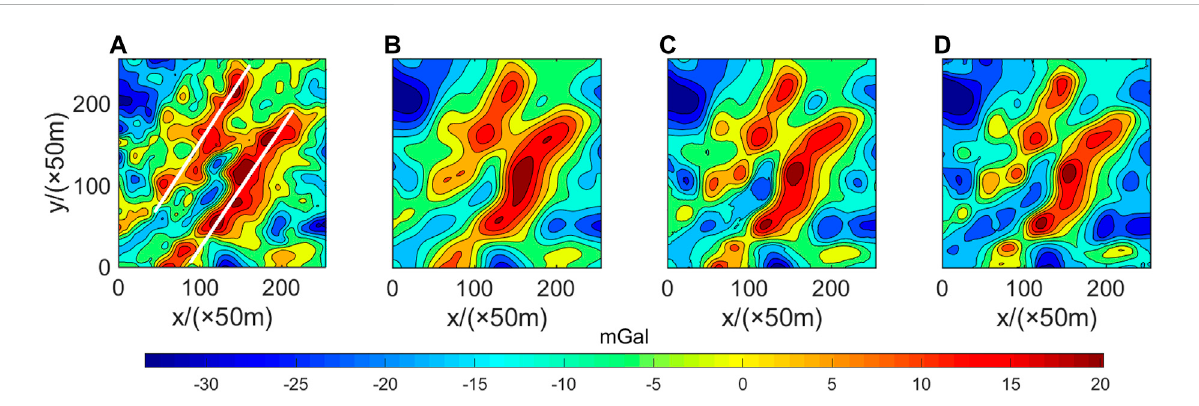
FIGURE 11 Actualexampletestdatawithtwofaults(whitelines) (A) andthedatacontinuedbyTikhonovregularization (B) ,jointdrivendata( 2input ) (C) ,and joint driven data with noise ( add noise ) (D)